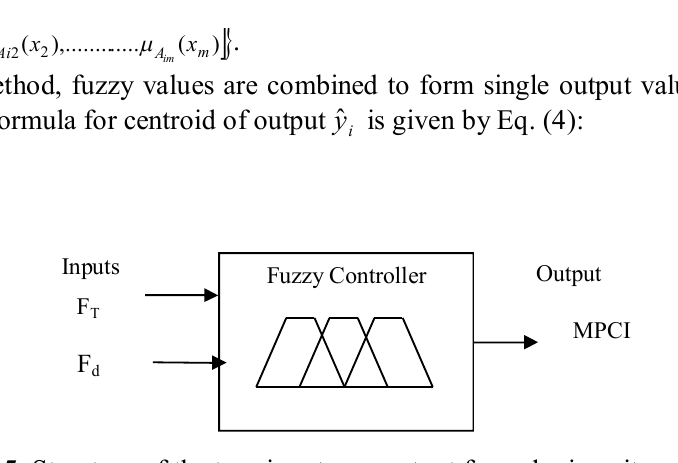
Fig.5 . Structure of the two-input-one-output fuzzy logic